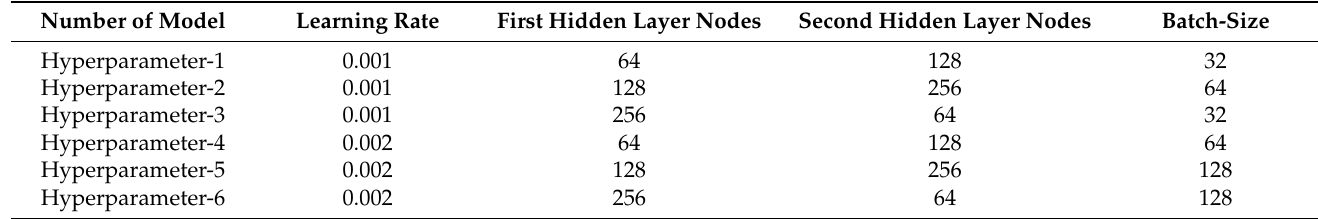
Table 4. Hyperparameter of different LSTM